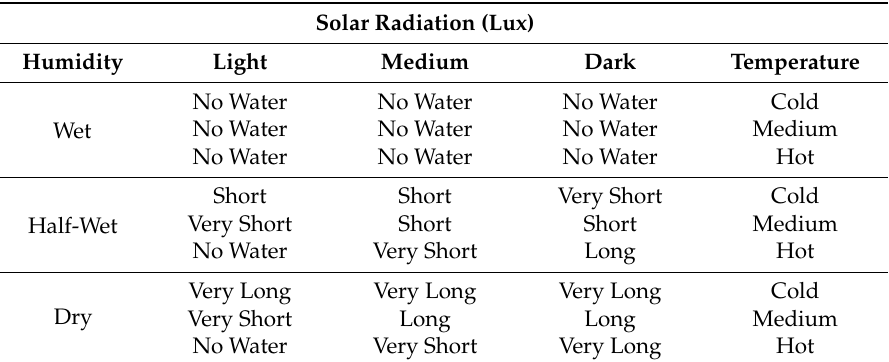
Figure 7. Rules provided by a human expert. Table 2. Rules for irrigation estimation time.